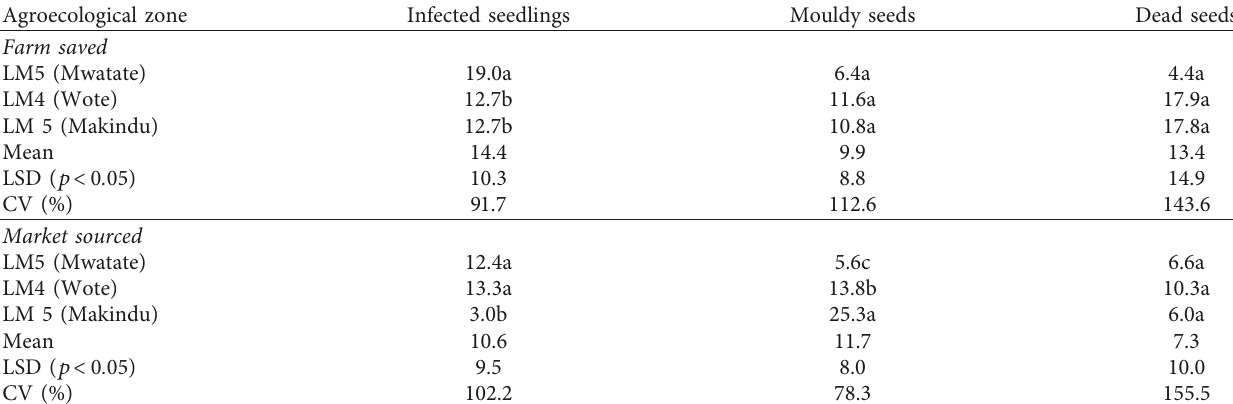
Table 6: Percentage of infected, mouldy, and dead seeds in farm-saved and market-sourced seeds in different agroecological zones in Makueni and Taita